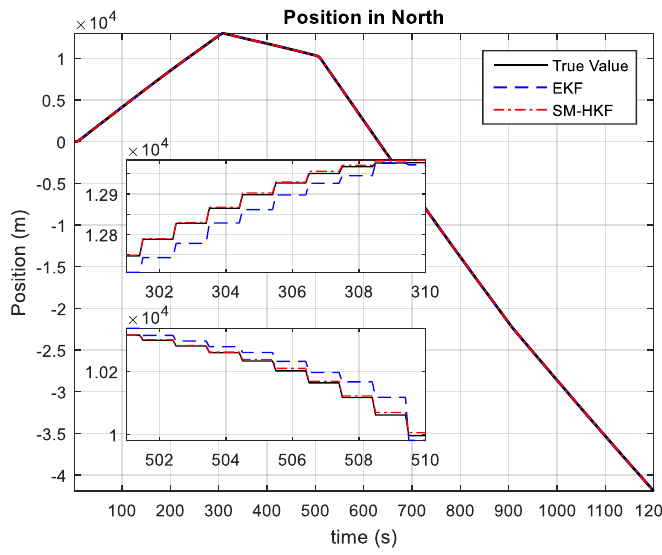
Figure 4. The positions in North estimated by EKF and SM-HKF.